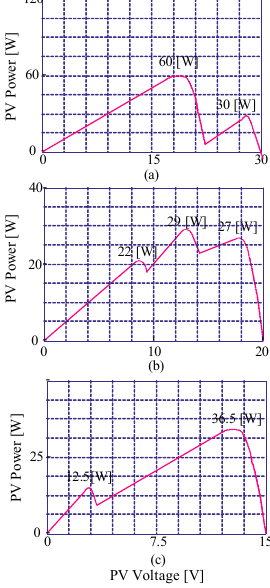
Figure 15. PV characteristics: ( a ) case 1, ( b ) case 2, ( c ) case